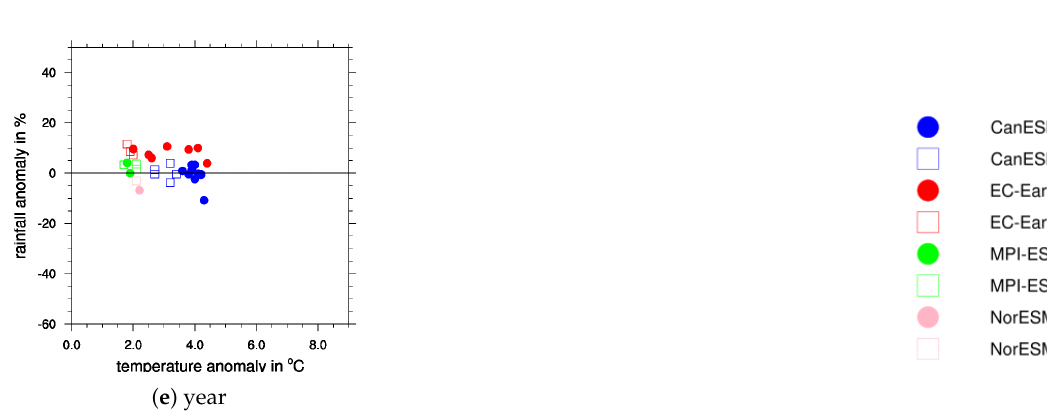
Figure A1. Comparison of EPISODES downscaling results based on RCP8.5 (CMIP5) and SSP5-8.5 (CMIP6) for Germany. The symbols (open: CMIP5; filled: CMIP6) show the Germany-wide mean climate change signal in annual/seasonal precipitation and temperature for 2041–2070 with respect to 1971–2000. Different colours correspond to different GCMs. (Seasons: ( a ) spring (MAM), ( b ) summer (JJA), ( c ) autumn (SON), ( d ) winter (DFJ), ( e ) year).